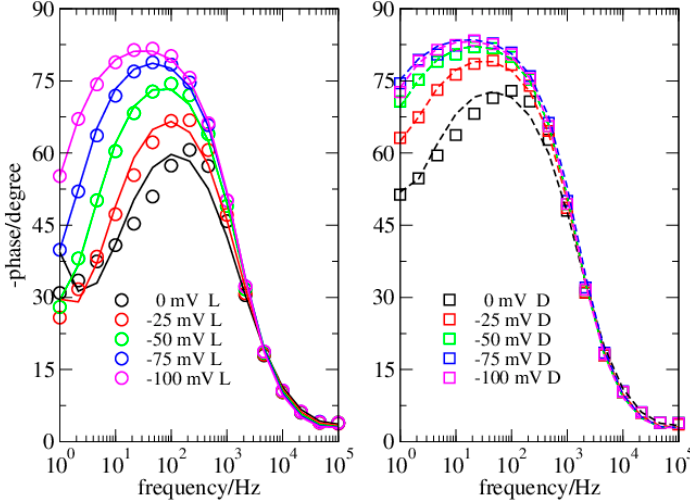
Figure 4. Dataset 2. Data in dark (squares) and light (circles). Lines reproduce data from simulations.